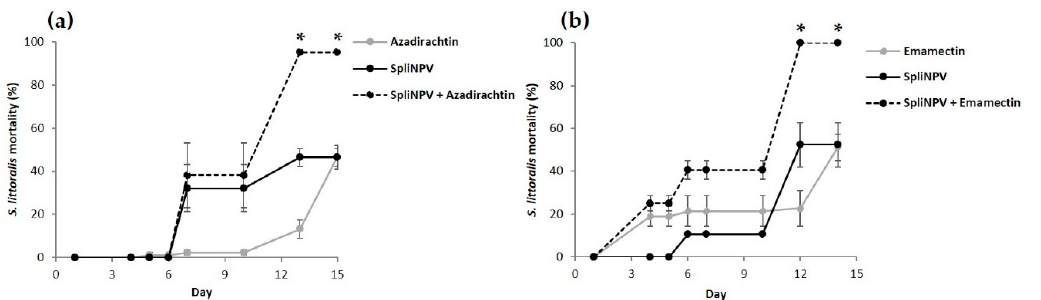
( e ) metaflumizone; ( f ) methoxyfenozide; ( g ) spinetoram; the LC 50 of SpliNPV or the sequential feeding of both over 10 min, and then maintained ad libitum on a semi-synthetic diet. The cause of death is represented by white bars for chemical insecticides and black bars for SpliNPV. Mock water controls are represented by gray bars. Significant χ 2 , showing synergy, are in bold. Tabular χ 2 with df = 1 and p ≤ 0.05 is 3.84.